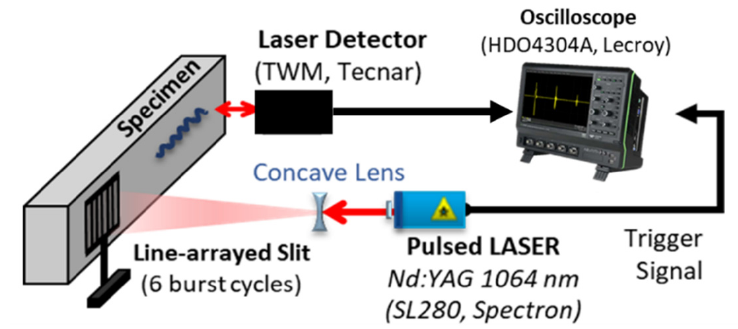
Figure 2. Experimental setup to generate and receive surface acoustic waves using the fully non-contact laser-ultrasonic technique.